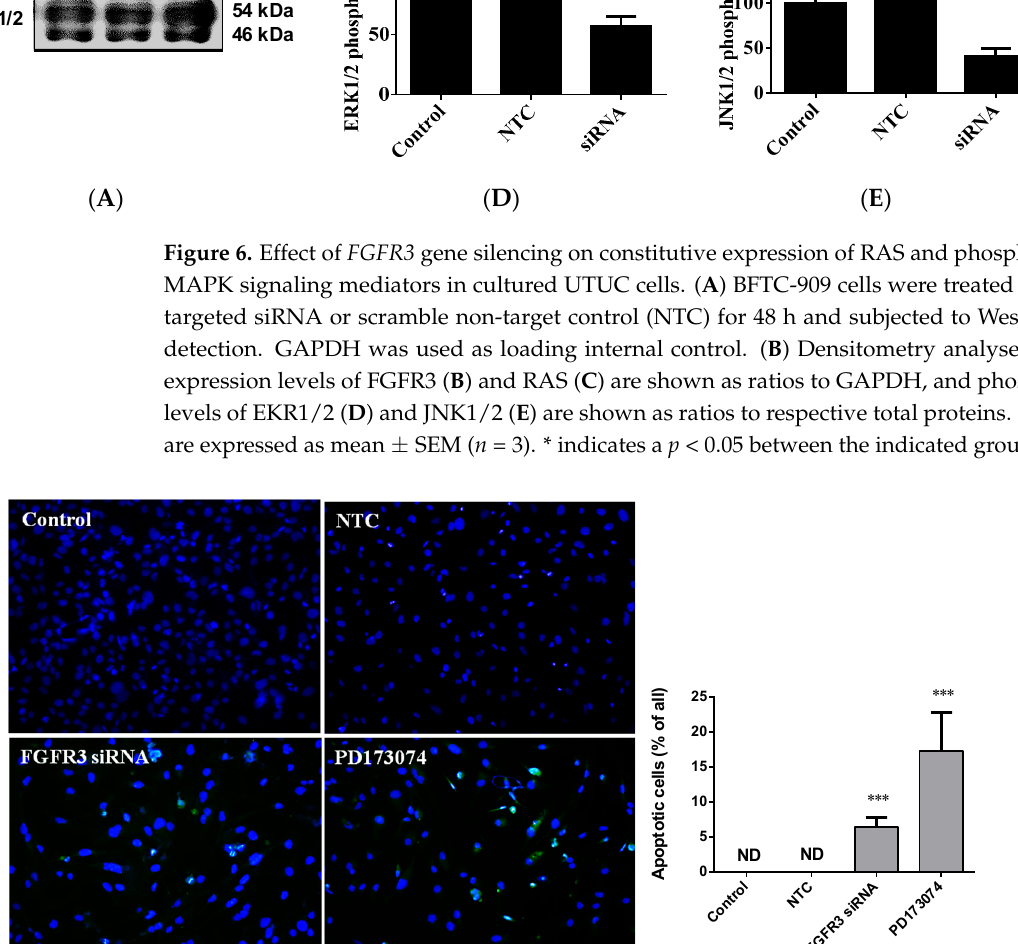
Figure 7. Effects of FGFR3 gene silencing and FGFR3 kinase inhibition on apoptosis of cultured UTUC cells. ( A ) BFTC-909 cells were treated with either FGFR3-targeted siRNA, scramble non-target control (NTC), or PD173074 at 10 nM for 48 h and subjected to TUNEL fluorescent staining. The TUNEL-positive apoptotic cells show green fluorescence, while DAPI blue fluorescence indicates nuclei of all cells. Original magnification: 100×. ( B ) Morphometry analysis on TUNEL-positive rates in the treated cells. Density data are expressed as mean ± SEM ( n = 8). *** indicates p < 0.001 vs. control group. ND, not detectable.